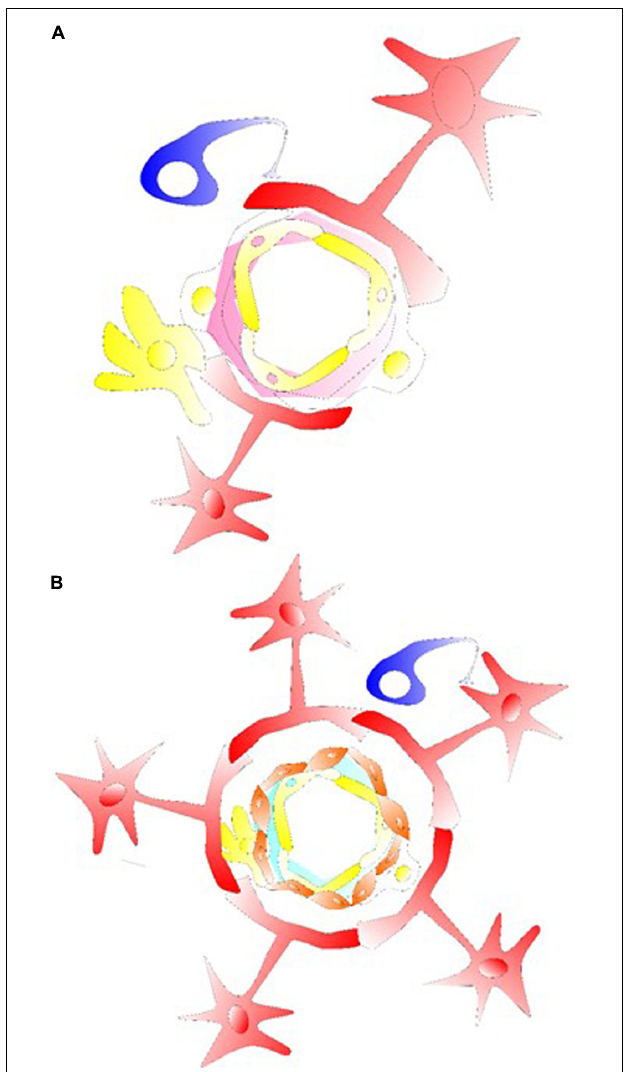
FIGURE 1 | Glial cells in their gliovascular unit. (A) The star shaped astrocyte (labeled red) with its end feet on the NVU and capillary component. Together with pericytes, astrocytes usually demonstrate the ability to regulate the capillary tone. This type of astrocyte can interact with pericyte or microglia/macrophage at the capillary levels, inducing an intracellular Ca 2 + increase via astrocytic P2X. Structures of tripartite synapses are not shown here, consisting of connecting presynaptic and postsynaptic compartments and their enveloping astrocytic process that may facilitate the mechanisms of neurotransmission and astrocytic Gaq/Ga11 GPCR signaling for Ca 2 + -dependent release of gliotransmitters and synaptic modulation via diacylglycerol kinase and PLD2-AA. (B) For astrocyte-arteriolar molecular crosstalk, the BBB, or at levels of neurovascular coupling, an endothelium vascular active mediator such as NO releases can affect the VSMC layer (labeled orange) such as to cause VSMC relaxation and arteriolar dilation. RBC is not labeled in the graph, but together with endothelial cells that under shear stress release ATP in the vessel to interact with endothelium P2X/P2Y generating/activating AA, cAMP/PGI2, eNOS, PGE2 and EETs. In here, the endothelial receptor may be targeted with acetylcholine, adenosine, ADPs, ATPs, bradykinin, and UTPs activating cAMP/PLA2/PLC, diacylglycerol-AA/EETs/PGI2 to cause VSMC relaxation. Astrocytic/neuronal ATPs are released activating VSMC P2X, P2Y, intracellular Ca 2 + to induce VSMC contraction for